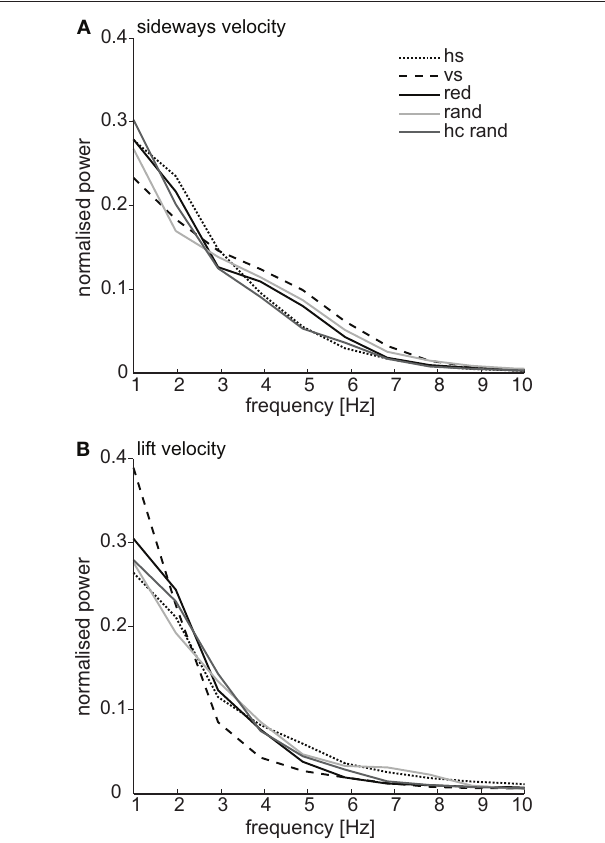
Figure 7 | Power spectra for sideways and lift velocity. Mean power spectra of the sideways (A) and lift (B) velocity normalized to the mean square amplitude are shown. For each part of a flight trajectory with a minimal length of 1024 ms where the bee was close ( < 100 mm) to the center of the labeled near landmark, the mean velocity (sideways or lift) was subtracted and the power spectrum of the respective velocity was calculated, normalized the area to unity and then averaged over all parts (hs n = 48, vs n = 30, red n = 38, rand n = 18, hc rand n = 19). For each landmark texture the normalized power spectrum is shown (for glossary and numbers of flights and bees see Figure 6 ). The dominant frequencies for the sideways and lift velocities are in the low-frequency range independent of the kind of texture. The medium power in the range of 4–6 Hz in the sideways velocity reveals a second prominent frequency component in the sideways movements of